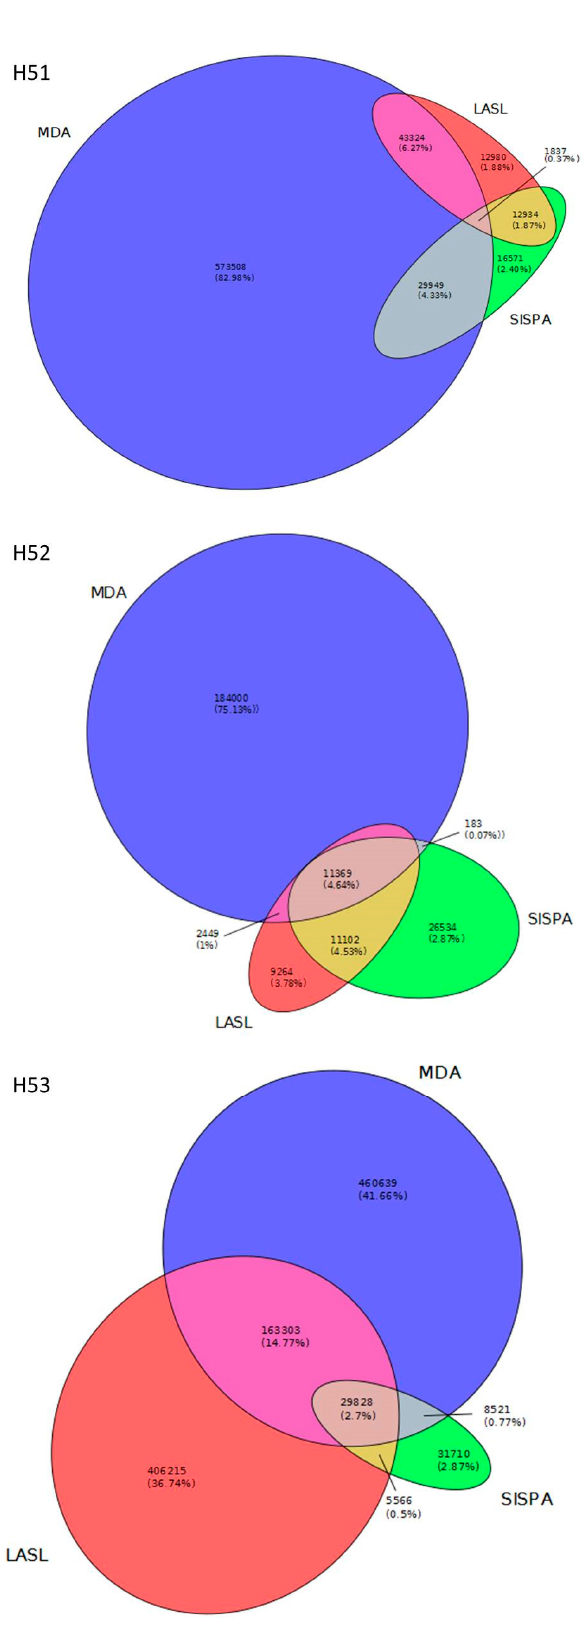
Figure 2. Overlap of sequencing read cluster (90% identity) information identified by library preparation methods, independently shown for each sampling site. Non amplified sequencing libraries (NASL) were not included in the analysis due to the homopolymeric and repetitive nature of sequences obtained from these